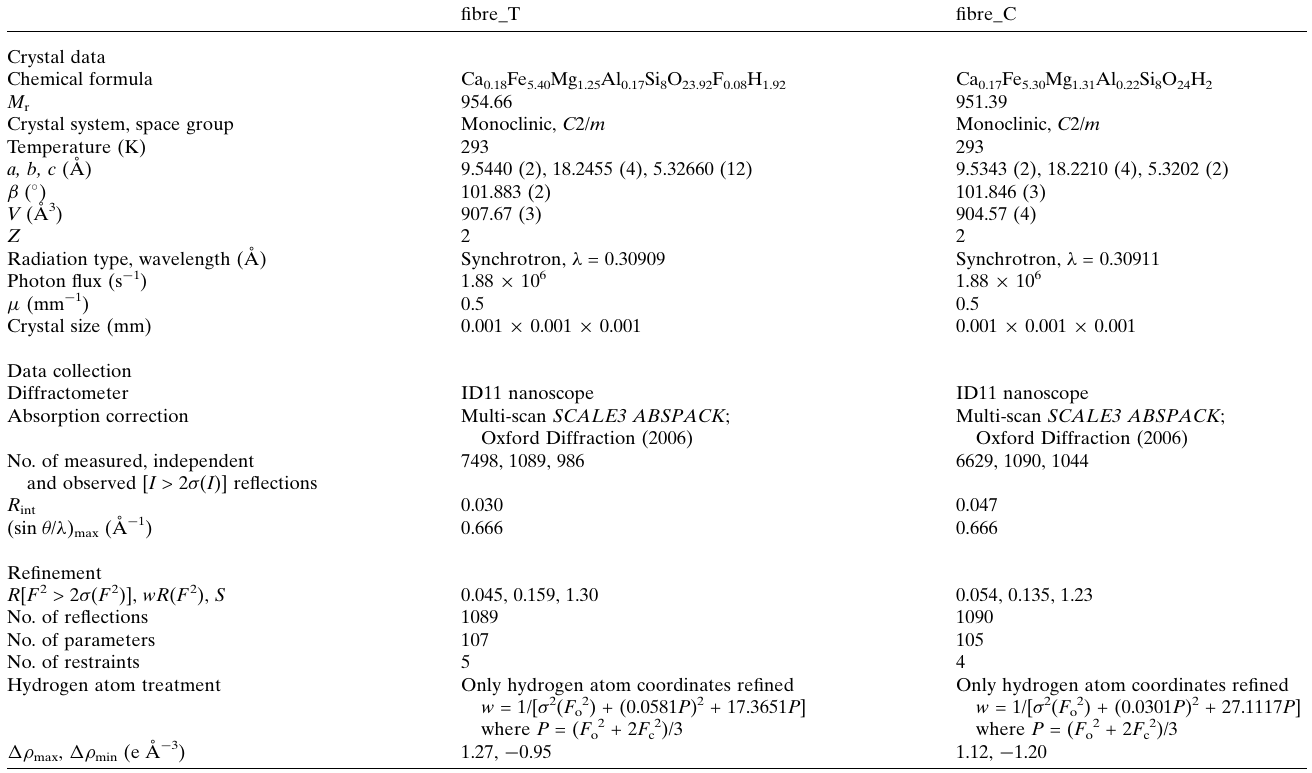
Table 1 Crystal data, data collection and structure refinement for fibre_T and fibre_C. Computer programs: SHELXL2014/7 (Sheldrick, 2015). Geometry. All ESDs [except the ESD in the dihedral angle between two least-squares (l.s.) planes] are estimated using the full covariance matrix. The cell ESDs are taken into account individually in the estimation of ESDs in distances, angles and torsion angles; correlations between ESDs in cell parameters are only used when they are defined by crystal symmetry. An approximate (isotropic) treatment of cell ESDs is used for estimating ESDs involving l.s. planes. Refinement. Refinement of F 2 against all reflections. The weighted R -factor wR and goodness of fit S are based on F 2 , conventional R -factors R are based on F , with F set to zero for negative F 2 . The threshold expression of F 2 > 2 (cid:3) ( F 2 ) is only used for calculating R factors, e.g. R [ F 2 > 2 (cid:3) ( F 2 )], and is not relevant to the choice of reflections for refinement. R factors based on F 2 are statistically about twice as large as those based on F , and R factors based on all data will be even